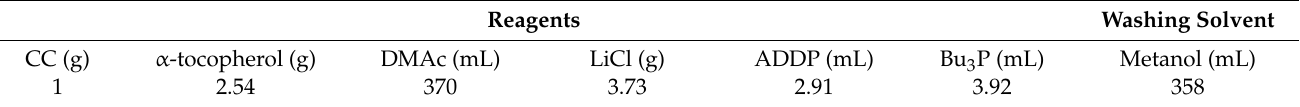
Table 1. Reagents and washing solvents of the synthesis of α -tocopherol and CC .